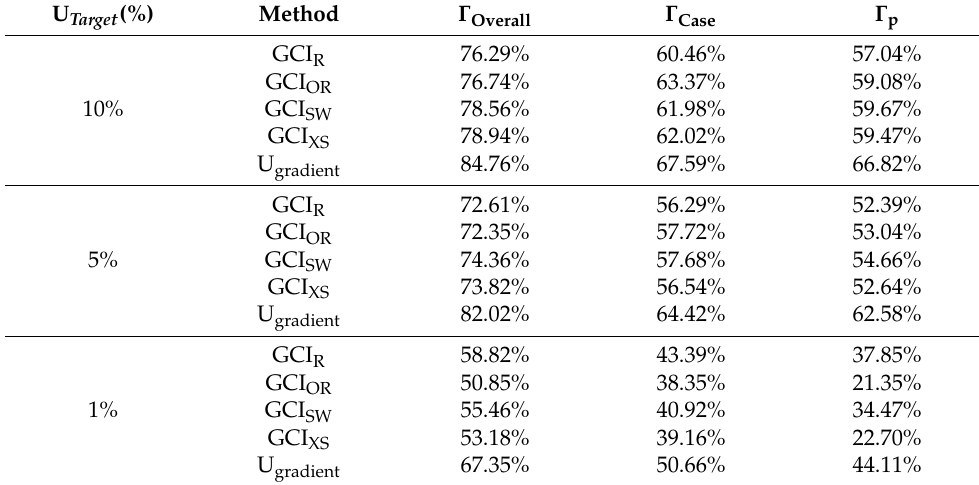
Table 3. Result of the Precision Test.